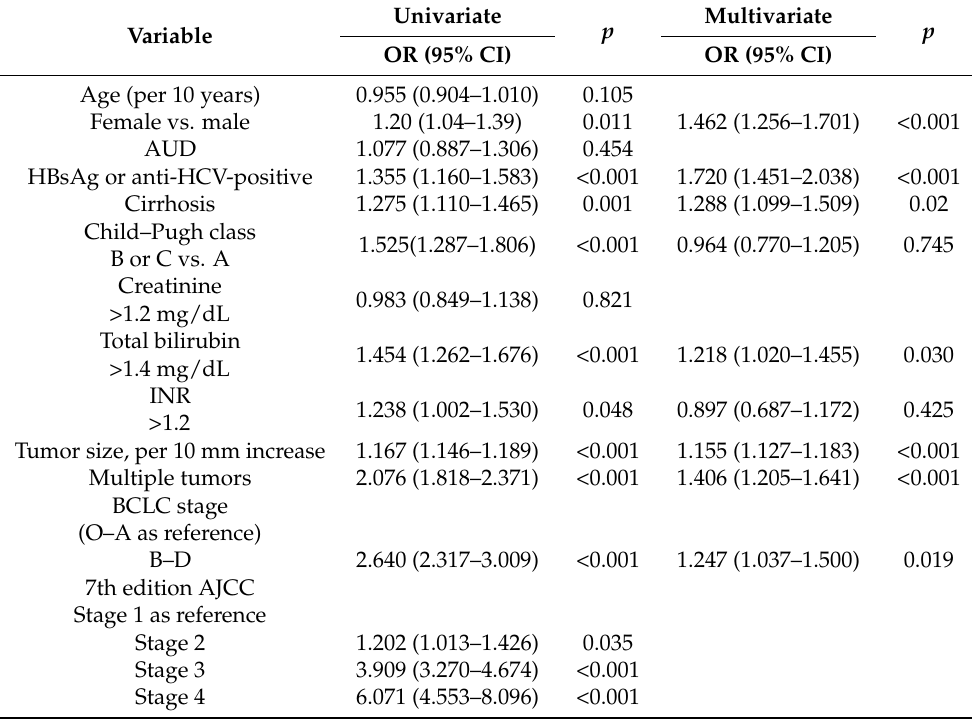
Table 2. Univariate and multivariate analyses of factors associated with elevated AFP levels.